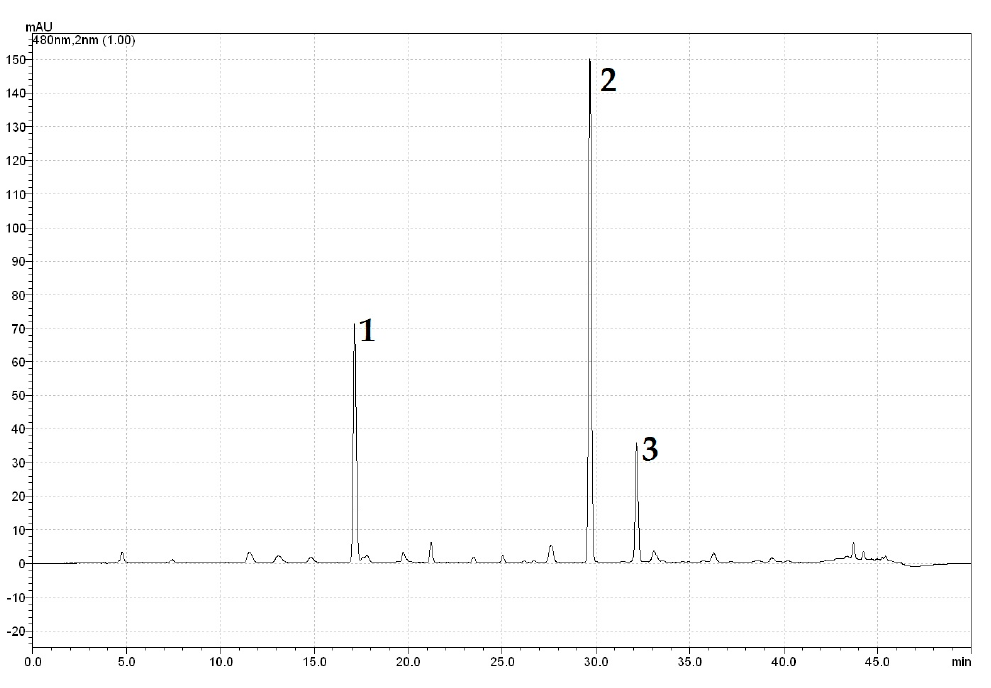
Figure A1. HPLC chromatogram of betalains at a wavelength of 480 nm: 1—vulgaxanthins I and II, 2—betanin, 3—isobetanin.